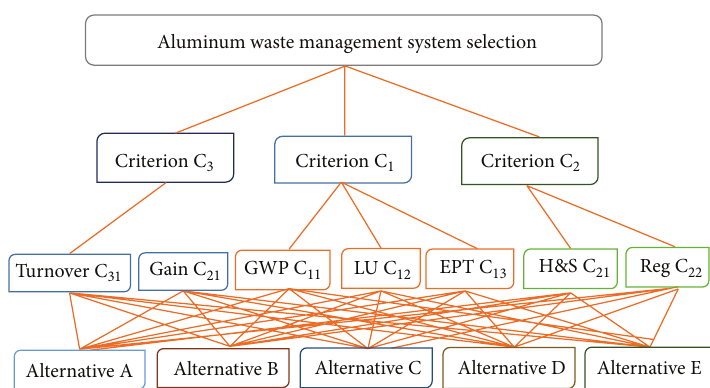
Figure 6: The hierarchical structure in the proposed research.